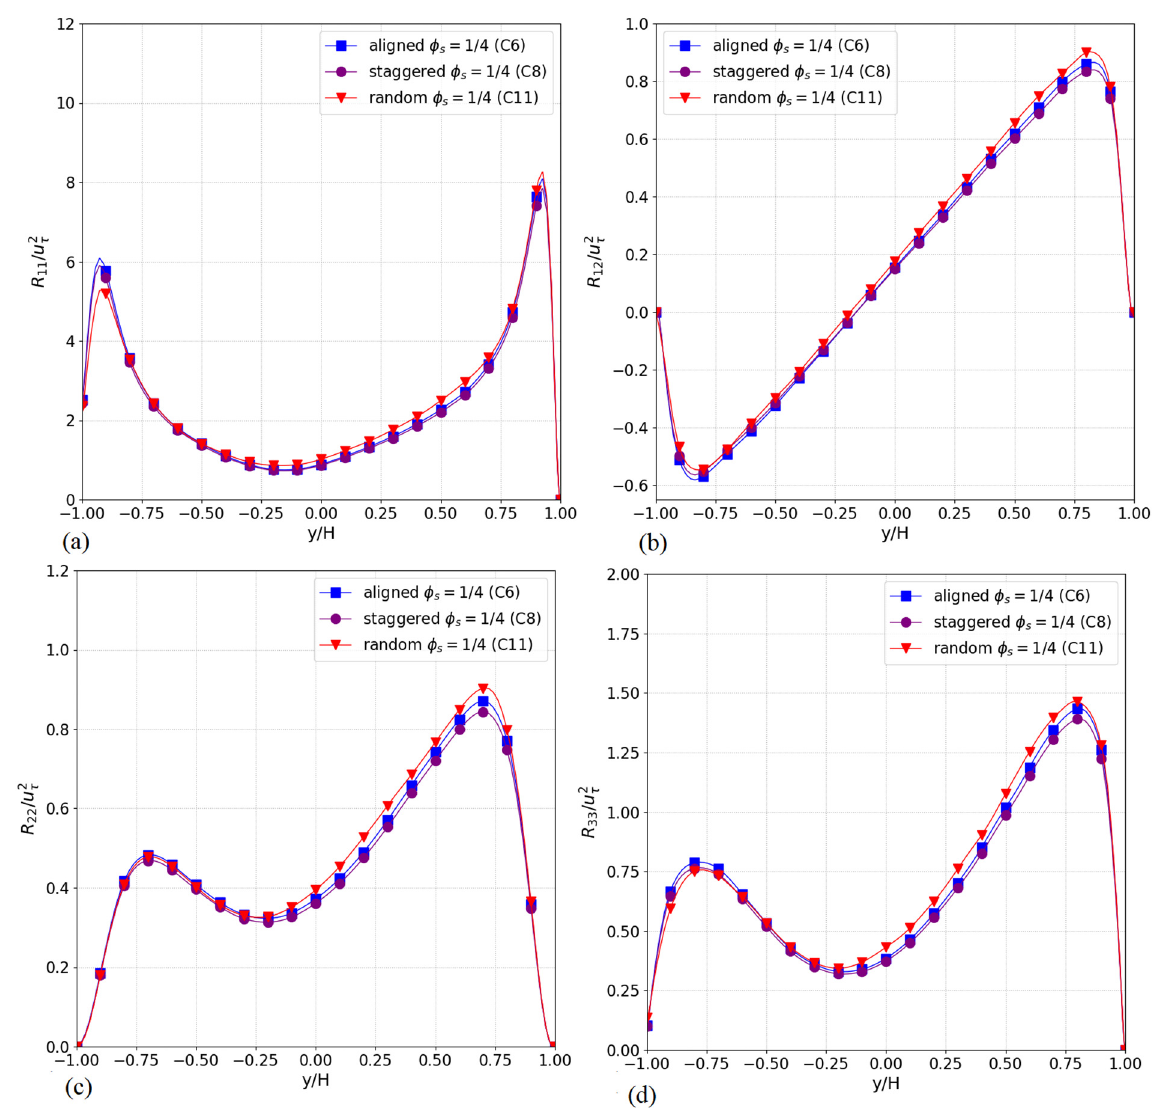
Figure 15. A comparison of Reynolds stress profiles for three different distributions at a solid fraction of φ s = 1 : ( a ) R 11 , ( b ) R 12 , ( c ) R 22 , and ( d ) R 33.